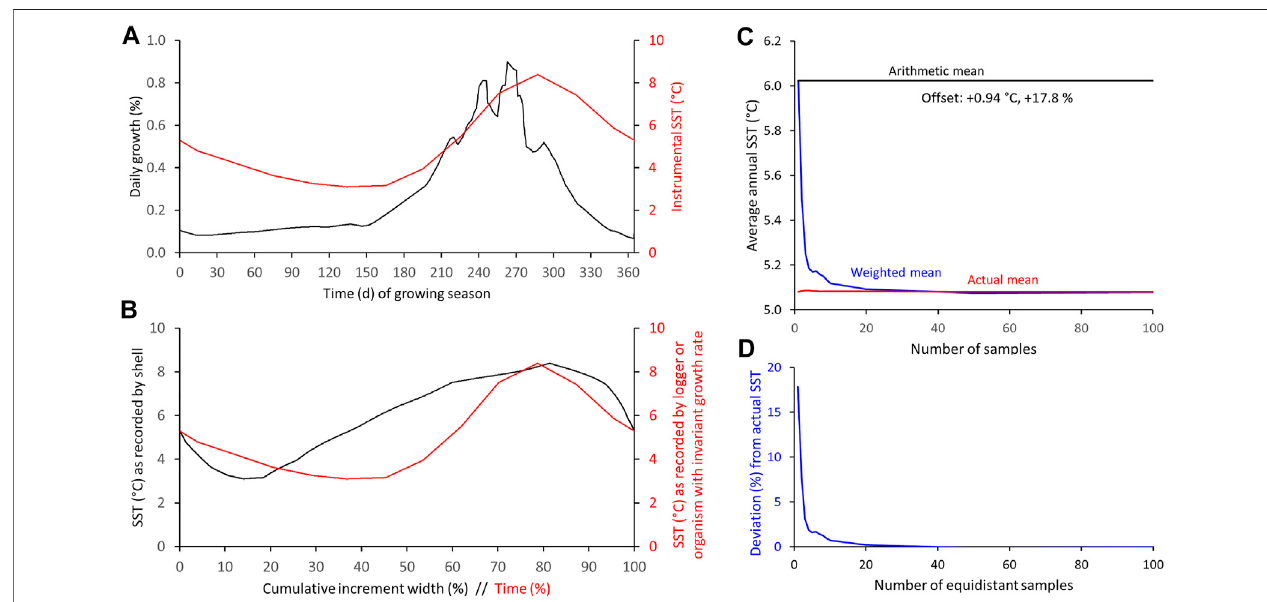
FIGURE 5 | Numerical simulation of differences between arithmetic and weighted annual means computed from intra-annual proxy-SST. (A) Seasonal growth model of Arctica islandica from NE Iceland in comparison to instrumental SST. (B) SST as recorded by shell (variable seasonal growth rate) and logger. (C,D) Arithmetic and weighted annual proxy-SST in comparison to actual SST mean. With increasing sample resolution, the weighted mean agrees better with the instrumental SST average (C) : absolute values; (D) : relative values.